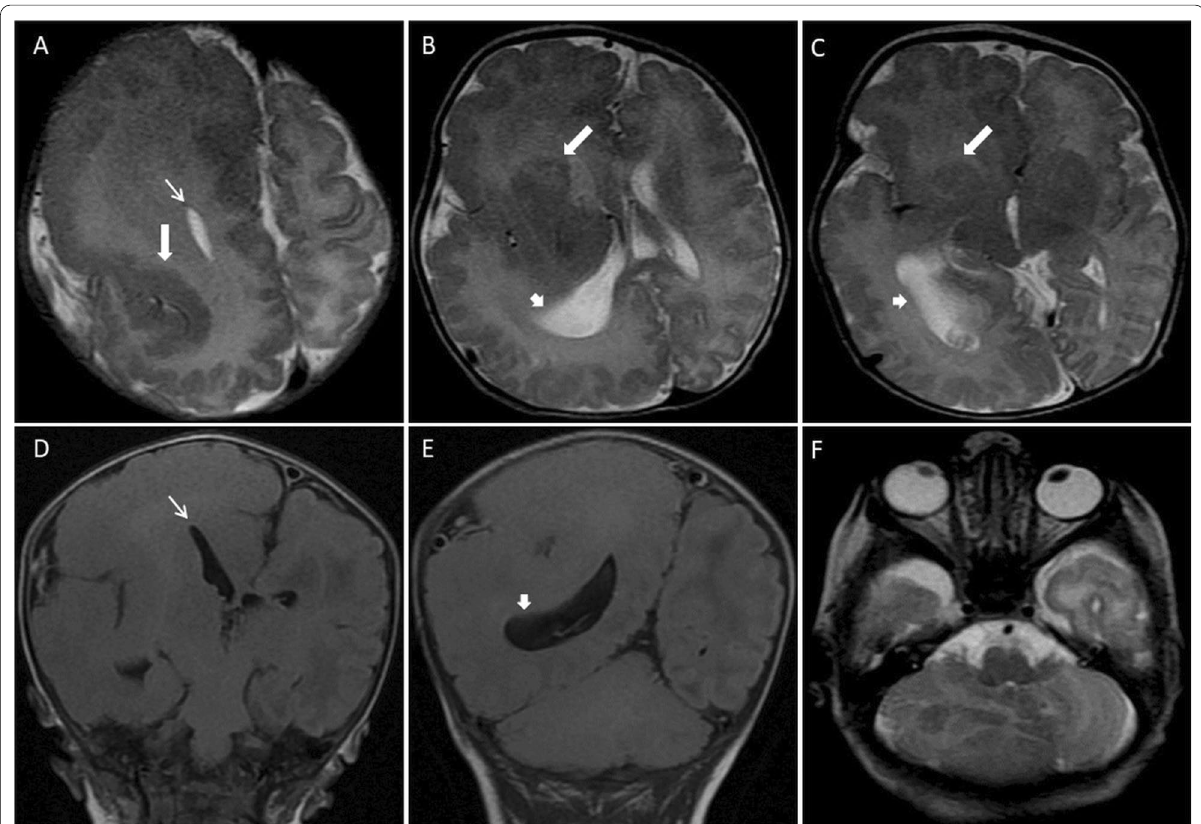
Fig. 1 MR images of a 9-day-old male with West syndrome and epilepsy ( a ), ( b ), ( c ), and ( f ) axial T2-weighted; ( d ) and ( e ) coronal T2 fluid-attenuated inversion recovery (FLAIR) series with right total hemimegalencephaly, diffuse polymicrogyria and heterotopic grey matter foci on the right (thick arrows), upward angulation in the frontal horn of the lateral ventricle (thin arrows) and colpocephalic dilatation (arrowheads) in the occipital horn and right cerebellar dysgenesis is